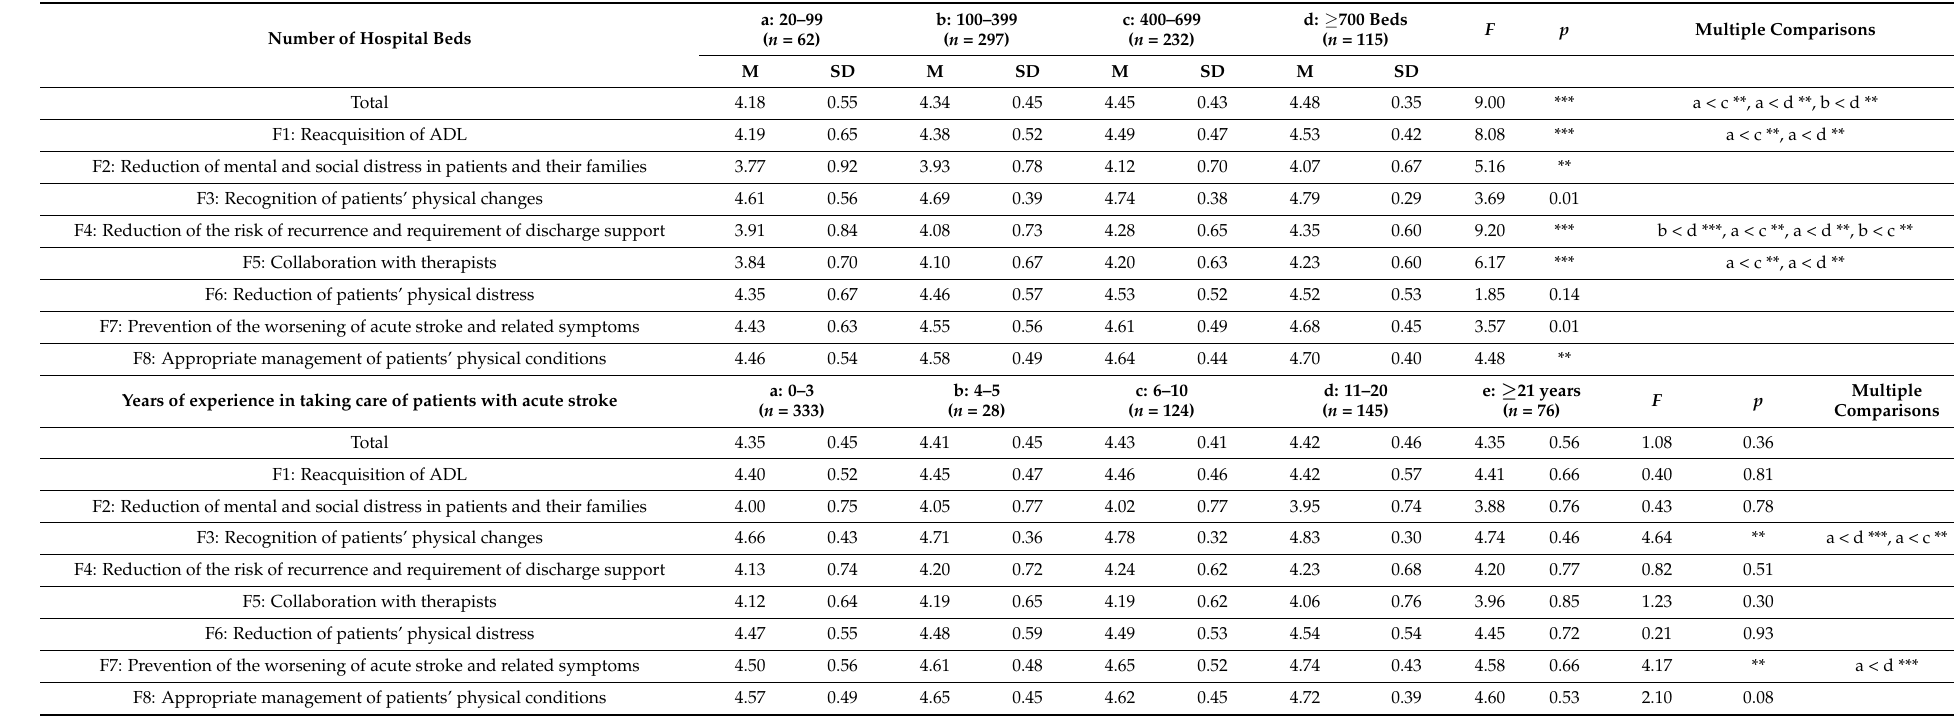
Table 5. Welch’s analysis of variance with Tamhane post hoc tests for actual